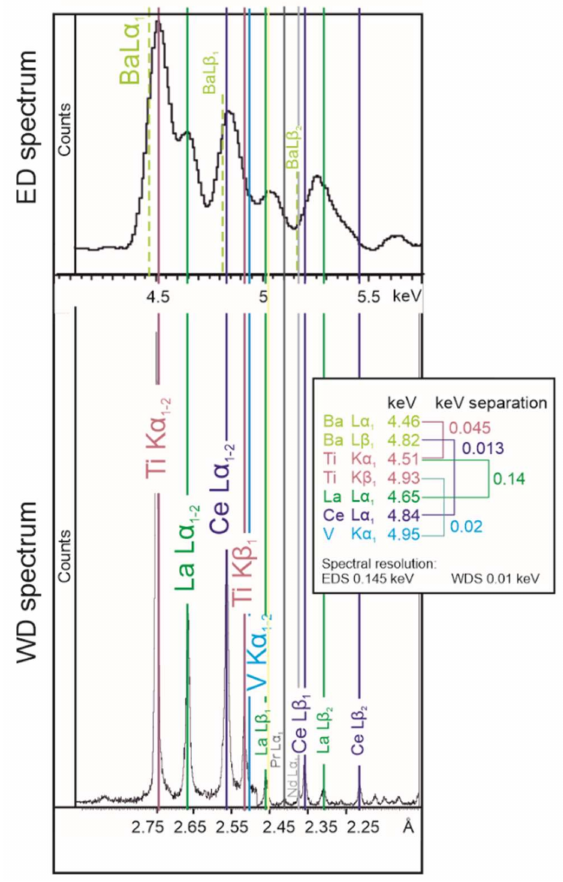
Figure 1. Illustration of the main X-ray overlaps in the 4.4–4.9 keV spectral region of the chevkinite mineral